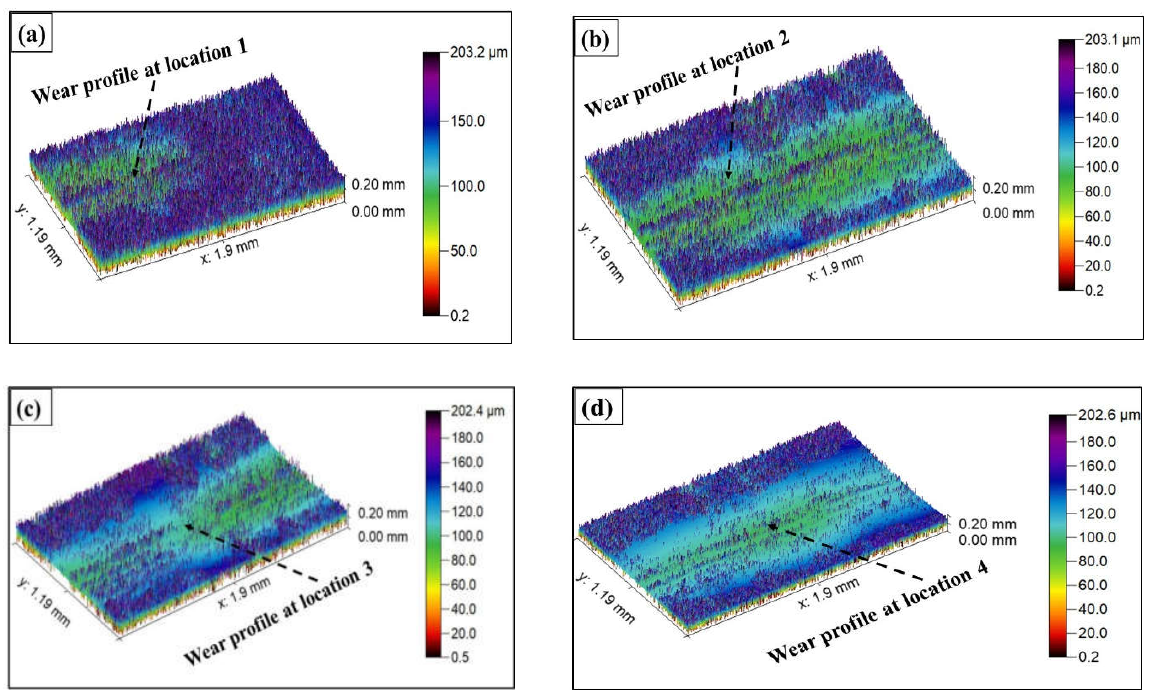
Figure 12. 3D image of the tribological wear track on FSPed composites during the ball-on-plate wear test as per the ASTM standard G133-05 at five different locations. ( a ) location 1; ( b ) Location 2 ( c ) Location 3 ( d ) Location 4